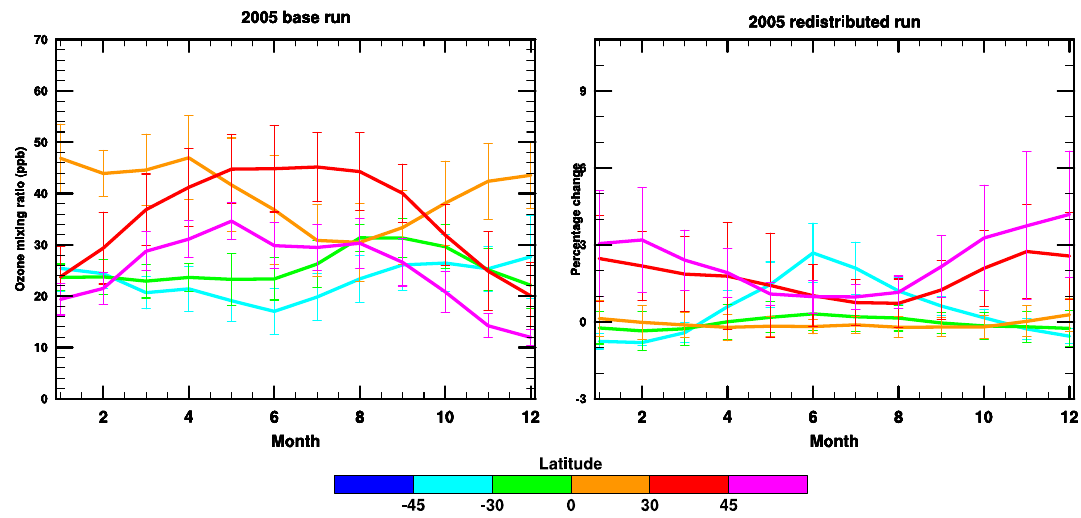
Fig. 6. Left panel: seasonal cycle of monthly mean ozone mixing ratio in model grid cells containing a megacity. Right panel: percentage change in monthly mean megacity ozone mixing ratio when megacity emissions are reduced by 25% and redistributed throughout the host countries. Means are presented for cities in latitude bands given by the color scale. Bars denote one standard deviation from the